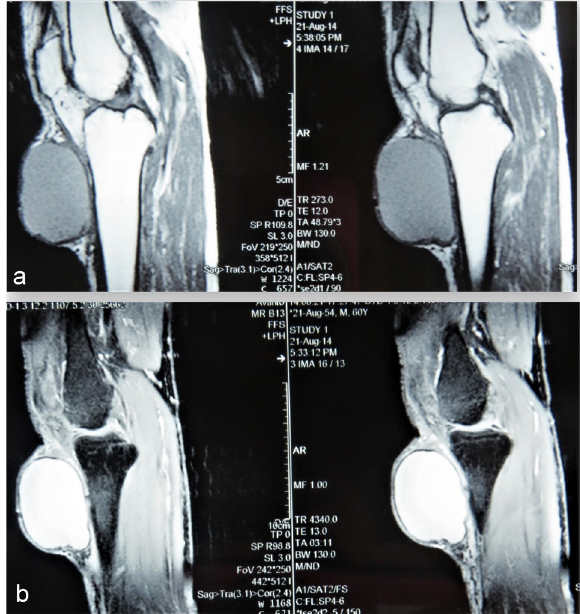
Figure 2. The MRI images showing the large bursa collection in saggital plane (a,b) depicting the infrapatellar bursitis.